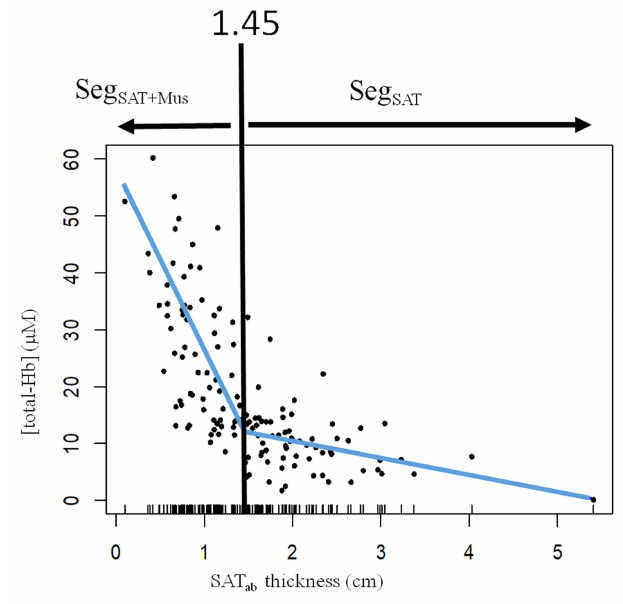
Figure 2. The relationship between total hemoglobin concentration (total-Hb) and the thickness of the subcutaneous adipose tissue (SAT ab